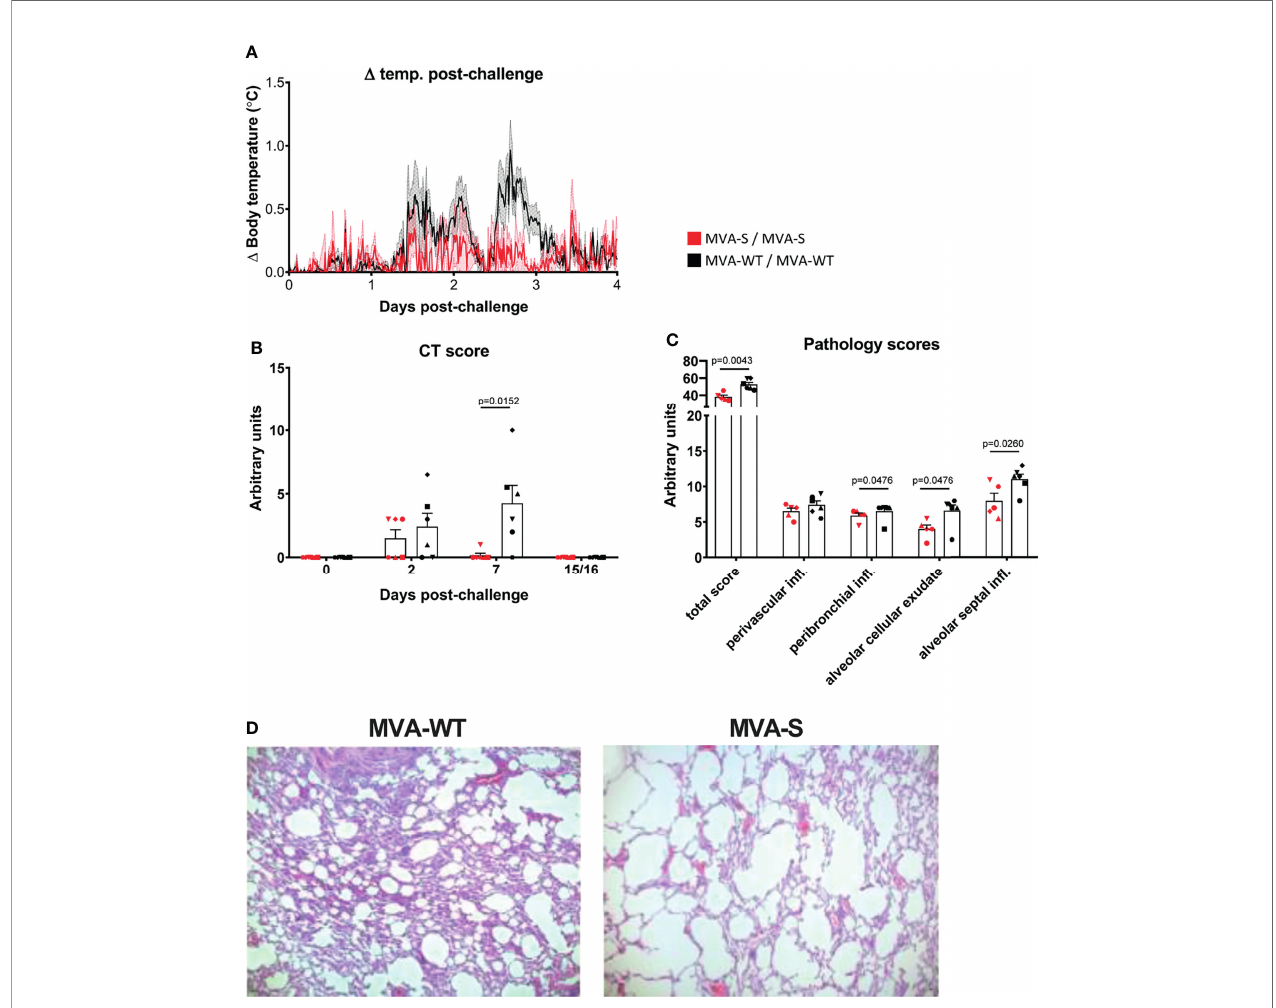
FIGURE 6 | Immunization with MVA-S reduced lung pathology. (A) Body temperature increase after SARS-CoV-2 challenge. Averages and SEM (shaded area) are represented per group. Body temperature was recorded every 15 min. Normal 24-h body temperature before challenge (mean of 7 days) was subtracted from post- challenge body temperature of each individual animal. Body temperature changes caused by sedation procedures are not included. (B) CT scores of MVA-S vaccinated (red) and MVA-WT control (black) animals at days 0, 2, 7, and 15/16 post SARS-CoV-2 challenge. Individual animals (symbols), averages, and SEM are shown in columns and bars for each group of animals. Maximum score per timepoint is 35. (C) Lung pathology score. Shown is the total pathology score as well as the scores for perivascular in fl ammatory in fi ltrates, peribronchiolar in fl ammatory in fi ltrates, alveolar cellular exudate, and alveolar septal in fl ammatory cells of MVA-S- vaccinated (red) and MVA-WT control (black) animals. Scores for animal r10067 (vaccinated with MVA-S) were excluded because this animal showed non-speci fi c vascular congestion, caused by the pentobarbital used for euthanasia. The maximum total score is 336, and the maximum score per individual parameter is 28. Signi fi cant differences between the groups are indicated in the graph by a horizontal line and p-value (Mann – Whitney test). (D) Lung histopathology. Lung histopathology on day 15 after infection. Shown is H&E staining on left middle lung lobe of animal r15067 (control MVA-WT) and animal r10003 (MVA-S). Original magni fi cation